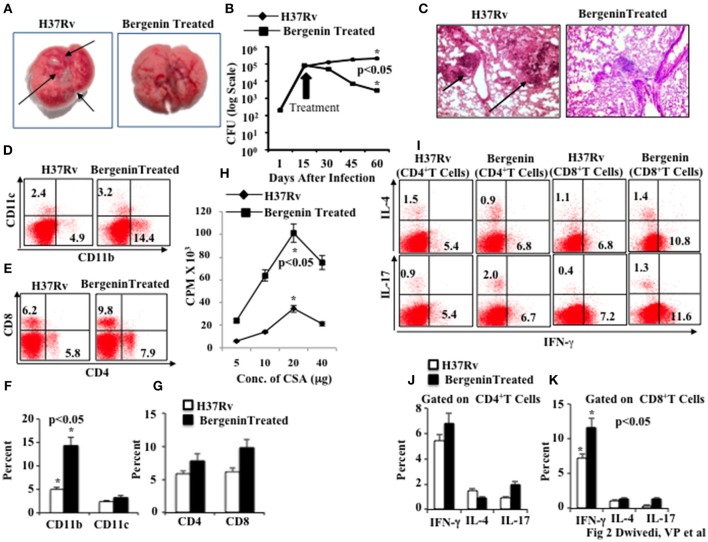
Immunomodulatory effect of bergenin on mice infected with Mycobacterium tuberculosis. (A) Macroanatomic pictures to show effects of bergenin on the lungs of H37Rv-infected mice. Arrows indicate the lesions in the lung of M.tb infected mice. (B) CFU from the lung homogenates of mice that were infected with H37Rv and treated with bergenin. (C) Histology pictures to show effects of bergenin on infection. Arrows indicate the granulomatic lesions in the lung section of M.tb infected mice. (D,F) FACS data to show the percentage of dendritic cells (CD11c+) and macrophages (CD11b+). (E,G) FACS data to show the percentage of CD4+ and CD8+ T cells. (H) Proliferation of splenocytes isolated from H37Rv-infected and bergenin-treated mice in response to CSA was measured by [3H]-thymidine incorporation assay. (I–K) Intracellular staining for IFN-γ, IL-4, and IL-17 of CD4+ and CD8+ T cells isolated from the spleen of H37Rv-and bergenin-treated mice. The results shown are representative of three independent experiments with six mice within each group. Error bars indicate means ± SD. *p < 0.05.